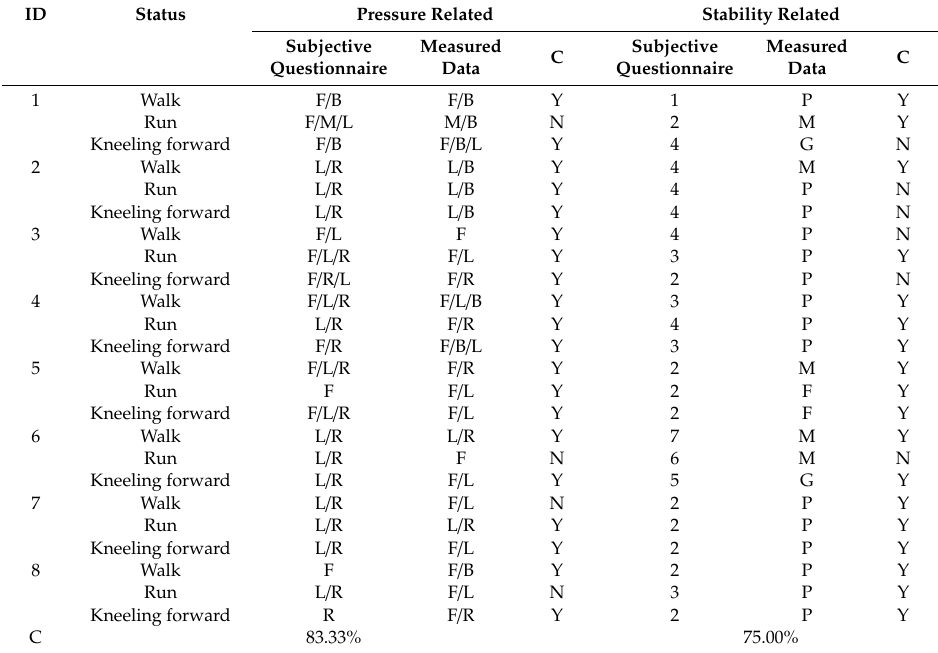
Table 3. Consistency statistics of the pressure and stability of the